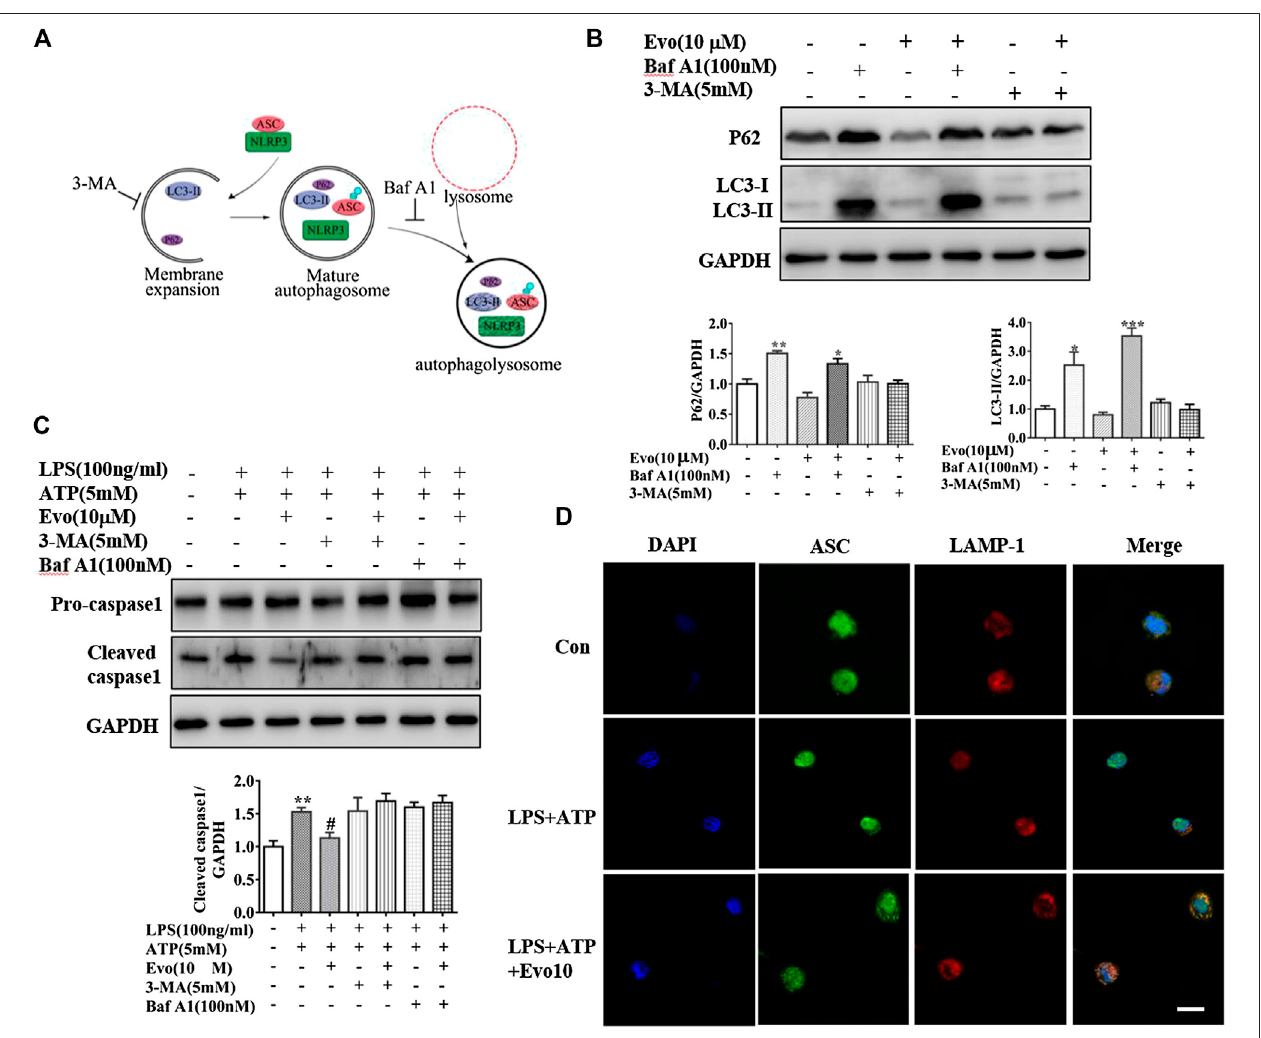
FIGURE 6 | Evodiamine inhibited NLRP3 in fl ammasome via the activation of autophagy. (A) Sketch of autophagy fl ux. (B) Immunoblot analysis of p62 and LC3 in THP-1 cells which were incubated with evodiamine (10 μ M) in the presence or absence of ba fi lomycin A (100 nM) or 3-MA (5 mM) and quanti fi cation. (C) Cleaved caspase one and pro-caspase one in THP-1 cells which were treated with ba fi lomycin A (100 nM), 3-MA (5 mM) alone or with Evo (10 μ M) after stimulation with LPS (100 ng/ml) and ATP (5 mM) were determined byImmunoblot. (D) Confocal microscopy images ofdifferentiated THP1 cells incubated with LPS and ATP with and without evodiamine, immunostained for ASC (green) and LAMP1 (red). Scale bars, 10 μ m. The results are representative of at least three independent experiments and expressed as mean ± SD. * p < 0.05, ** p < 0.01, and *** p < 0.001 compared with the control, # p < 0.05 compared with the LPS + ATP group.